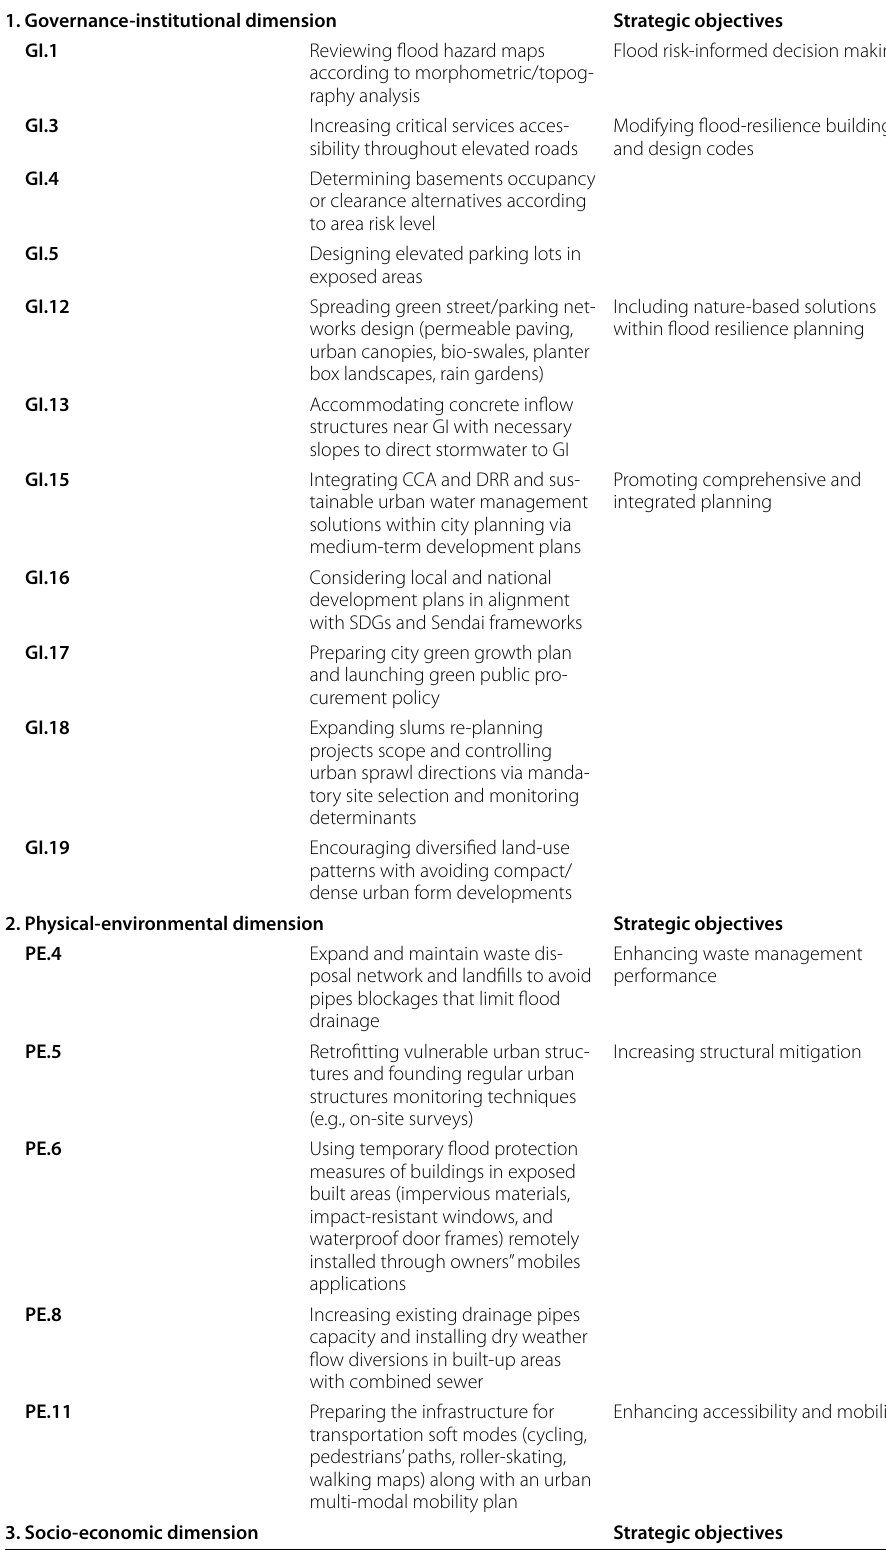
Table 7 Prioritized urban resilience strategies 1. Governance-institutional